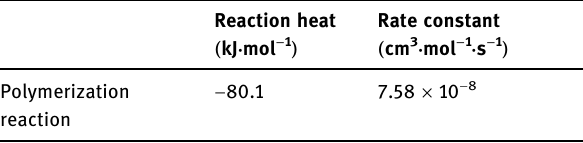
Table 1: Reaction thermodynamics and kinetic